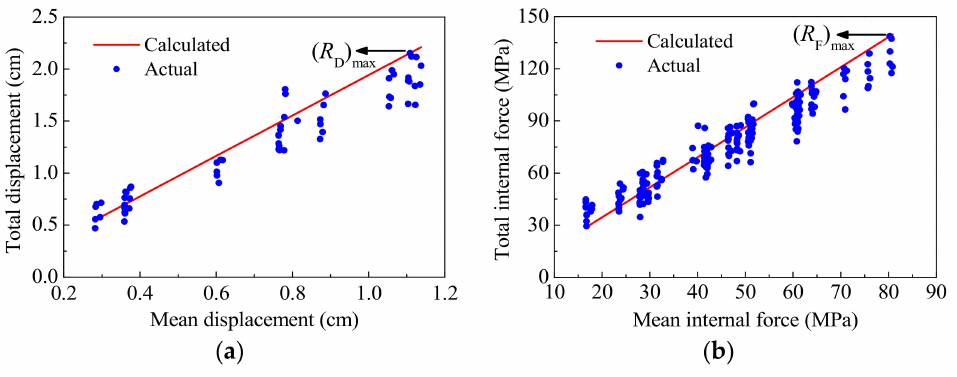
Figure 10. Comparisons of the structural total responses: ( a ) nodal displacement; ( b ) elemental internal force.